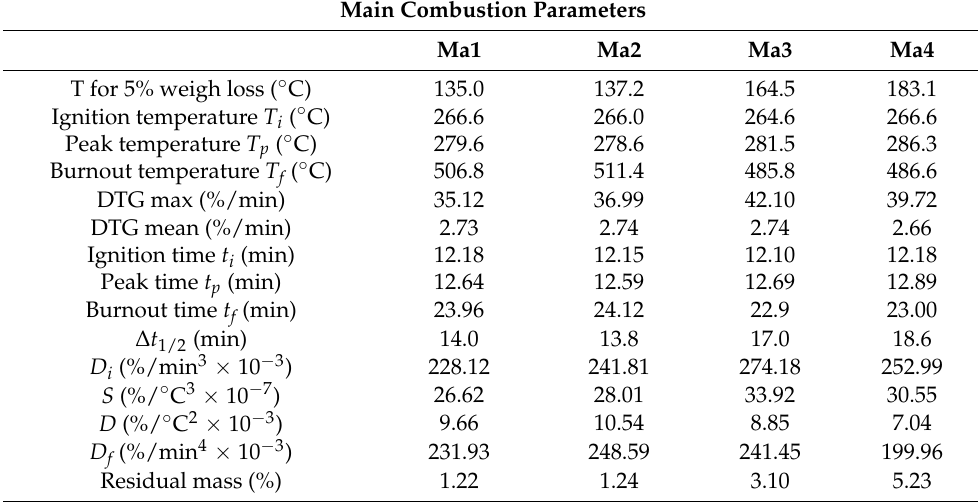
Table 4. Main combustion parameters (air